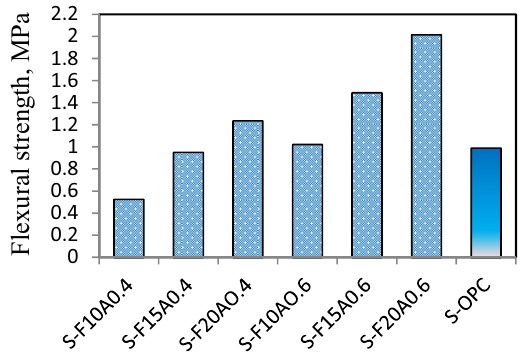
Figure 5: Flexural strength.